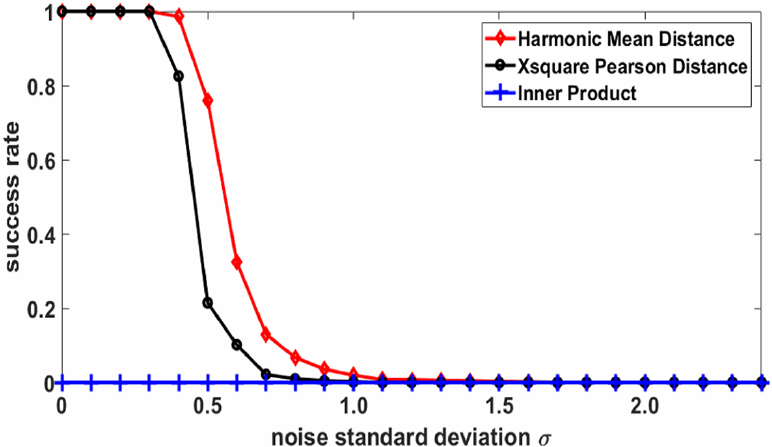
Figure 3. Success rate according to noise standard deviation (using two random variables).